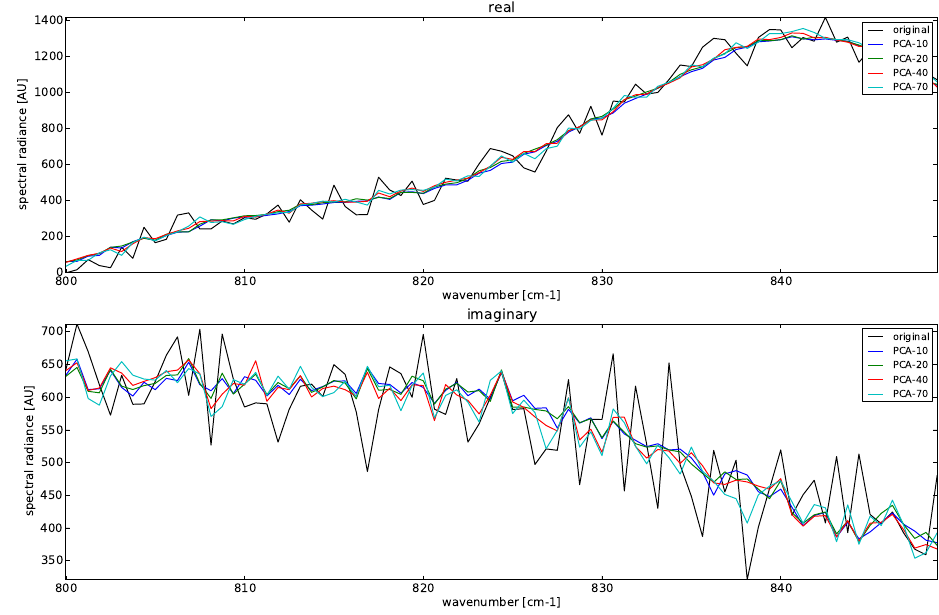
Figure 8. The same reconstructions as in Fig. 6 but in a limited spectral range between 800 and 850cm − 1